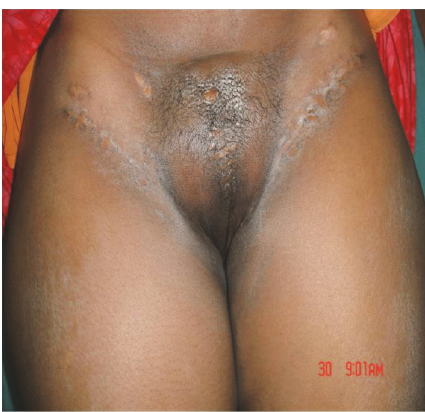
Figure 4: Inguinofemoral block dissection.